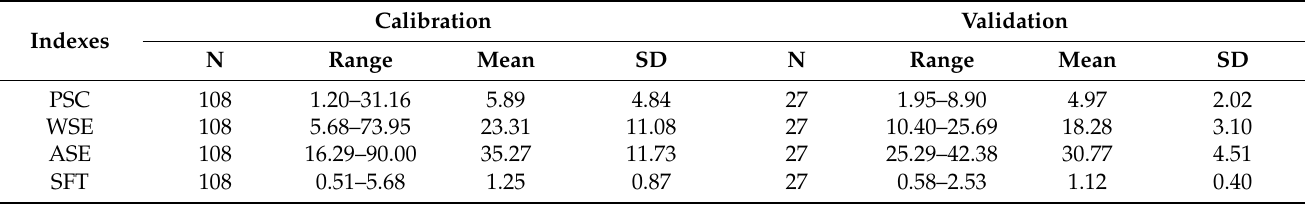
Table 4. Range of values obtained by the reference methods for PC samples in the calibration and validation sample